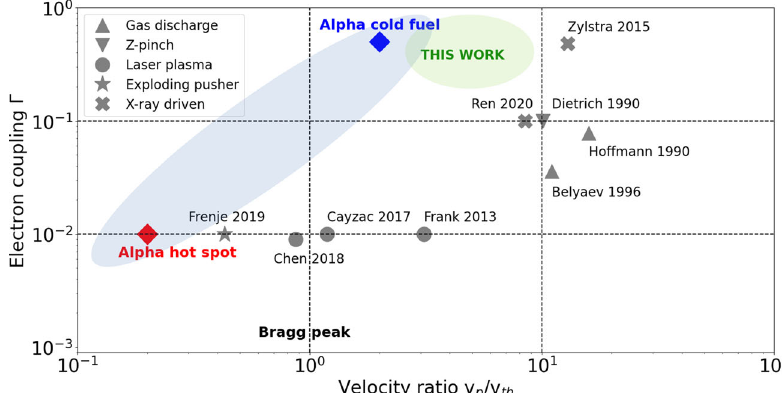
Fig. 1 Selection of reported ion-stopping experiments. Experiments displayed in the parameter space of the velocity ratio v p / v th of the beam-plasma interaction and the target electron coupling Γ . The grey symbols mark the plasma generation method used. The shaded blue zone represents the approximate range of v p / v th and Γ values corresponding to the α -particle emission in an igniting ICF experiment, ranging from the cold fuel to the hot spot conditions. The experiment described in this work, indicated by the shaded green zone, lies in an unexplored parameter range that is relevant for α -particle stopping conditions in the cold